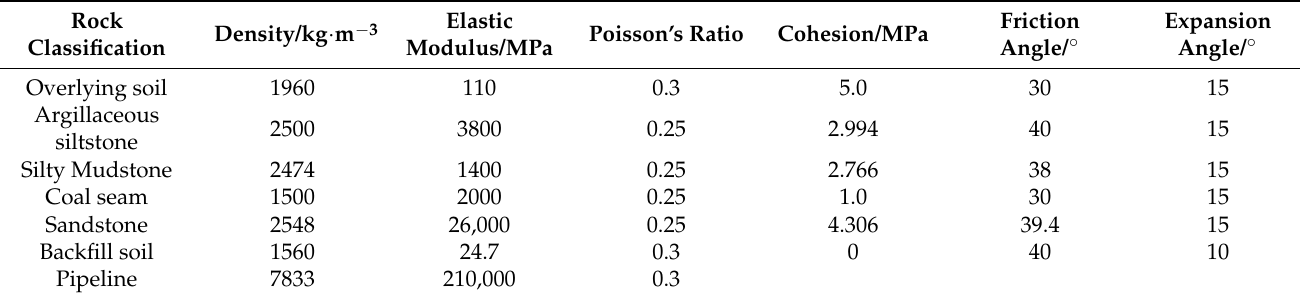
Figure 1. Geometric model of natural gas pipeline through goaf. Table 1. Physical parameters of the pipeline and rock strata.